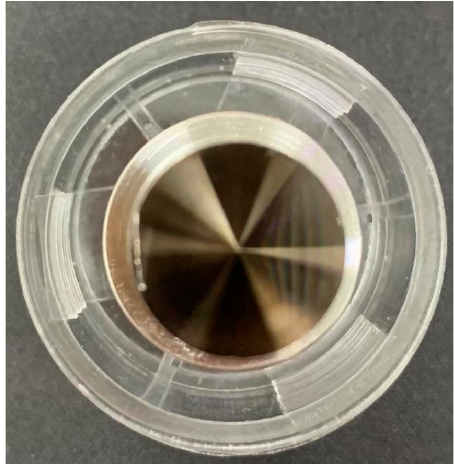
Figure 10. Cemented carbide mold.